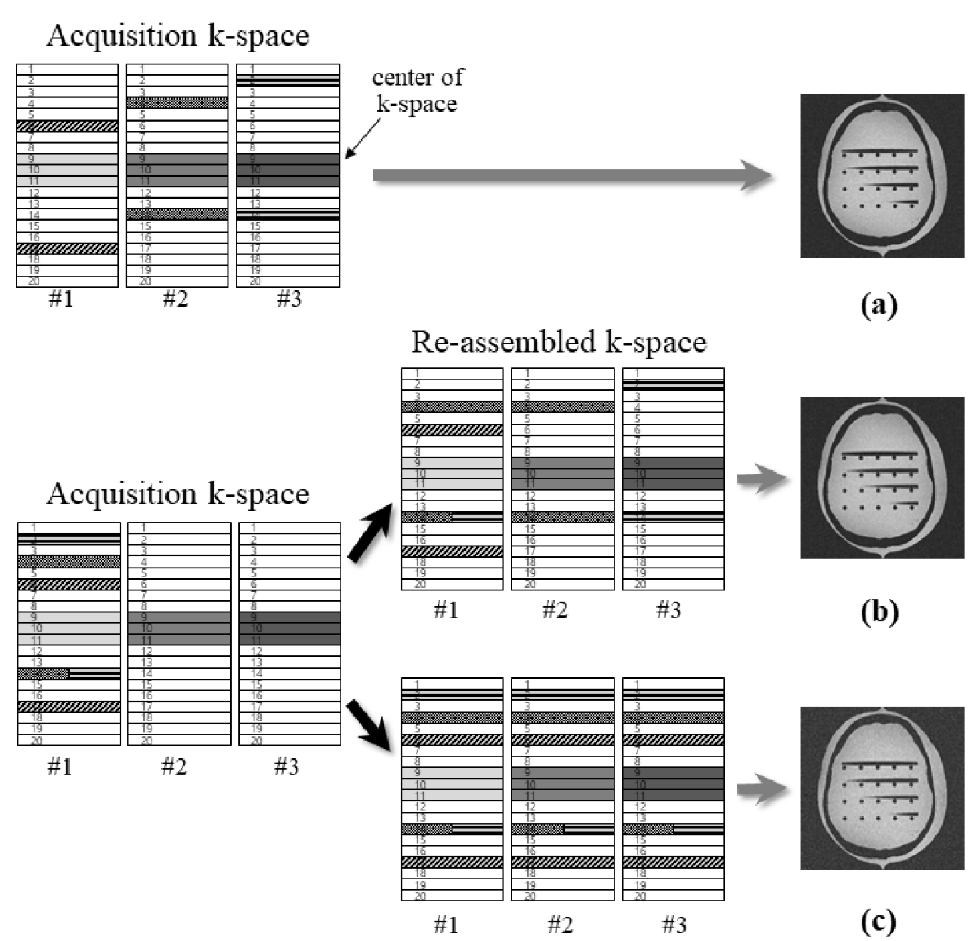
Figure 1. Conceptual schemes of CSA techniques. ( a ) CSAM which has pseudo-randomly sampled high-frequency k-space lines during acquisition; ( b ) CSAK based on k-space sharing (CSAKS); ( c ) CSAK based on k-space copying (CSAKC). The numbers, #1, #2, and #3, indicate the independently acquired subsets. Different gray levels at each k-space center (i.e., 9, 10, and 11) represent different acquisitions. Boxes with different background shapes belong to the pre-allocated lines in subset 1. Gray arrows indicate the CS reconstruction process for generating the image.